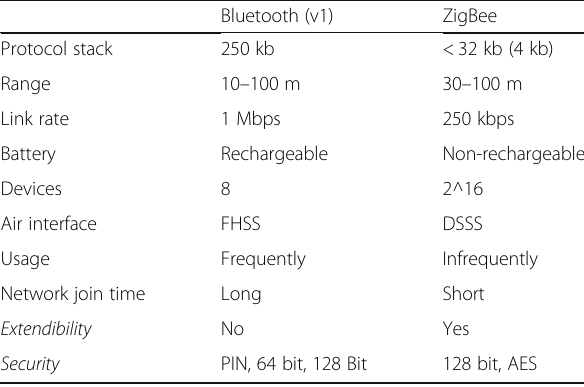
Table 1 Bluetooth vs. ZigBee